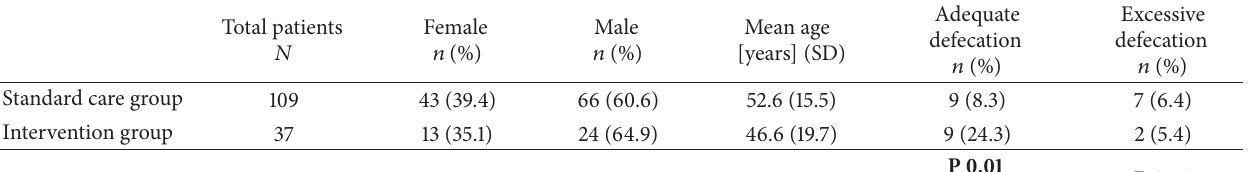
Table 2: Standard care and intervention group. Adequate defecation was observed significantly more often in the intervention group, whereas excessive defecation was seen as frequent in intervention group and in standard care group.